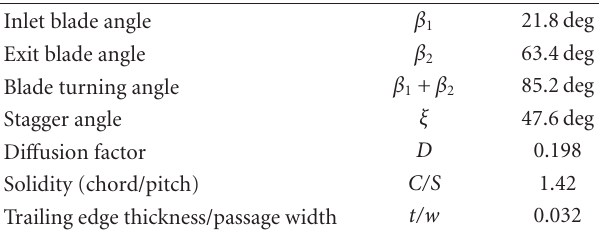
Table 1: Nondimensional parameters of corresponding turbine rotor